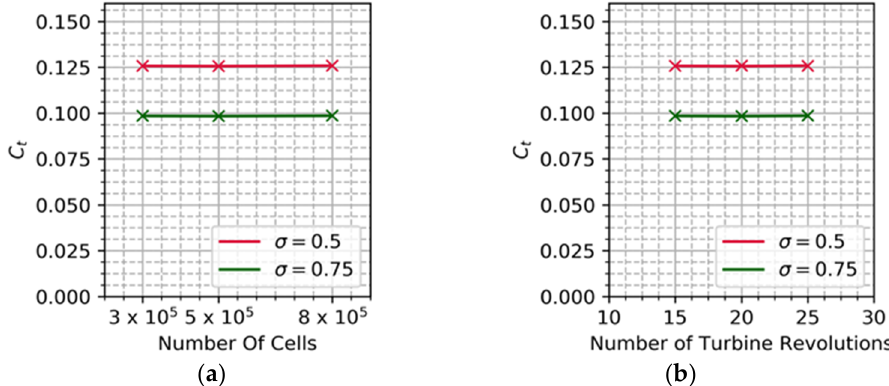
Figure 4. ( a ) Grid independence study on different solidity. ( b ) Time step on different solidity.